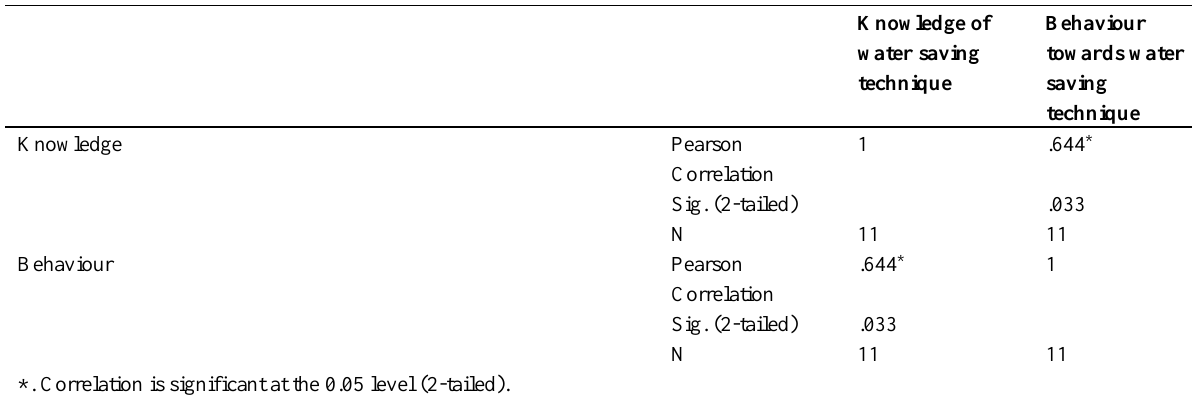
Table 3 : Pearson